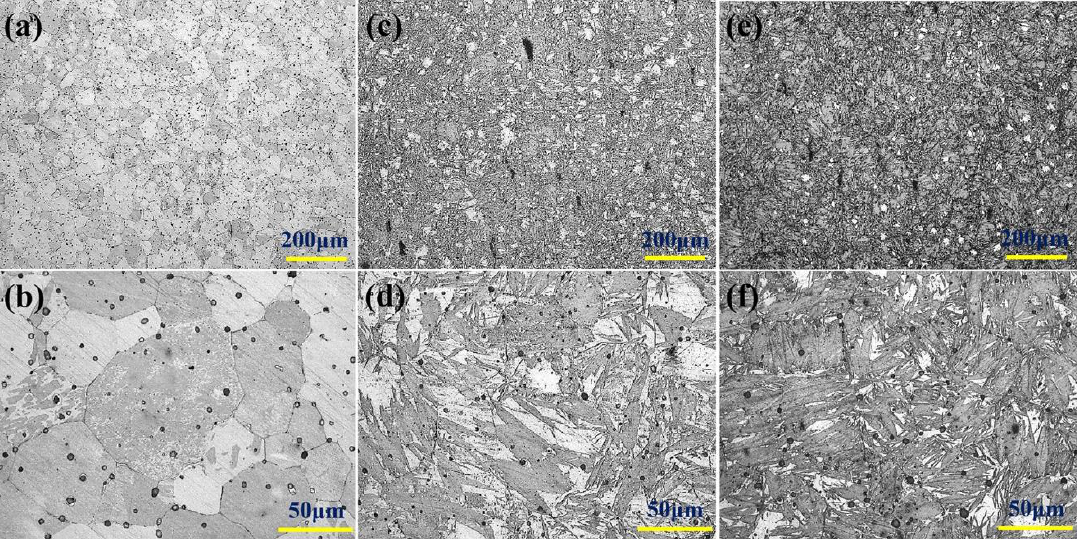
Figure 2. Microstructure of Fe-Ni-P alloys before/after cryogenic treatment: ( a , b ) 20 °C; ( c , d ) −20 °C; ( e , f ) −50 °C.